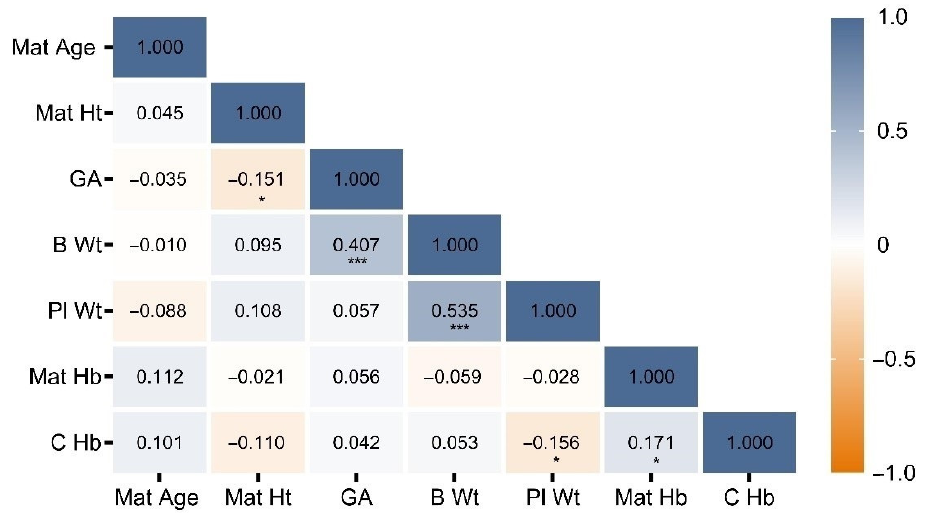
Figure 1. Correlation matrix showing Pearson’s coefficients of the bivariate (unadjusted) analysis. * p < 0.05, *** p < 0.01. B,